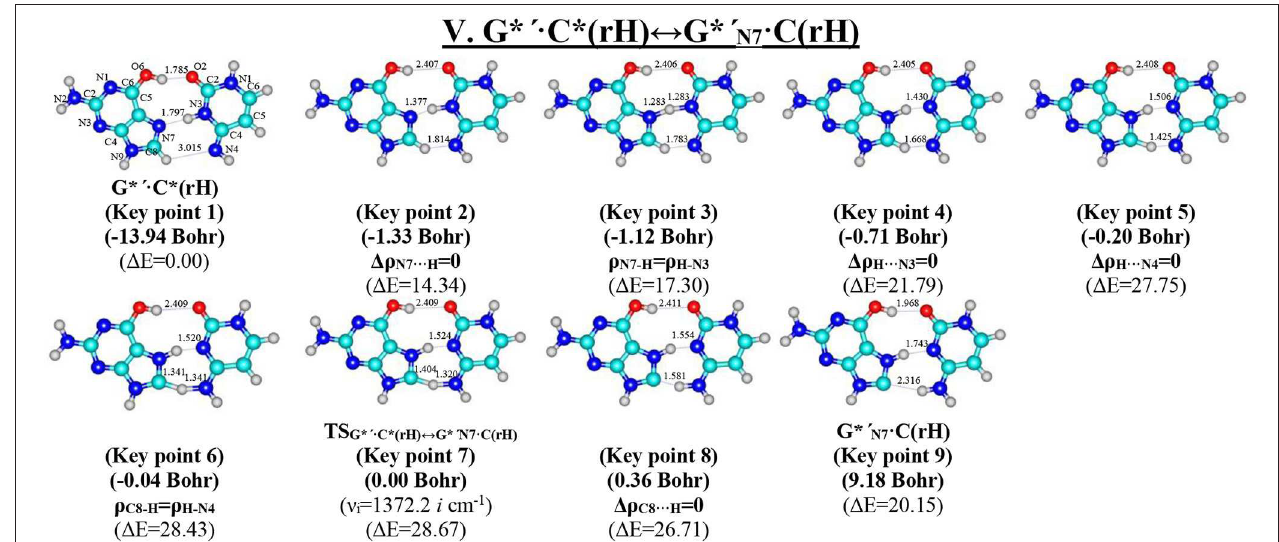
FIGURE 10 | Geometric structures of the 9 key points describing the evolution of the V. G* ′ at the B3LYP/6-311 G(d,p) level of theory in vacuo (see Table 7 ). For more detailed designations see Figure 2 ++